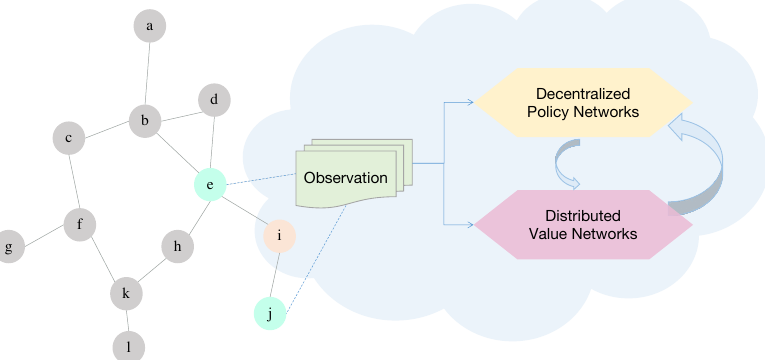
Figure 1. The proposed multi-agent graph on the left and a detailed look at the internal architecture of each agent on the right. Other observable neighbor agents of each agent are depicted by gray edges, for instance the e -th agent and j -th agent are neighbor agents of the i -th